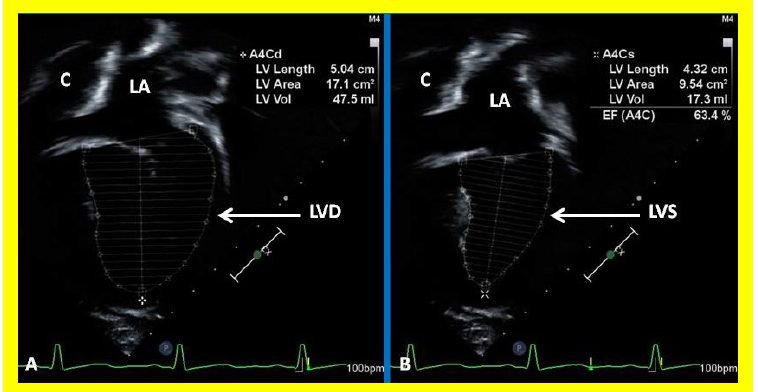
Figure 38. Selected video frames showing left ventricle (LV) in diastole (LVD) ( A ) and in systole (LVS) ( B ) demonstrating normal ejection fraction (EF) of 63.4%. C, conduit; LA, left atrium.